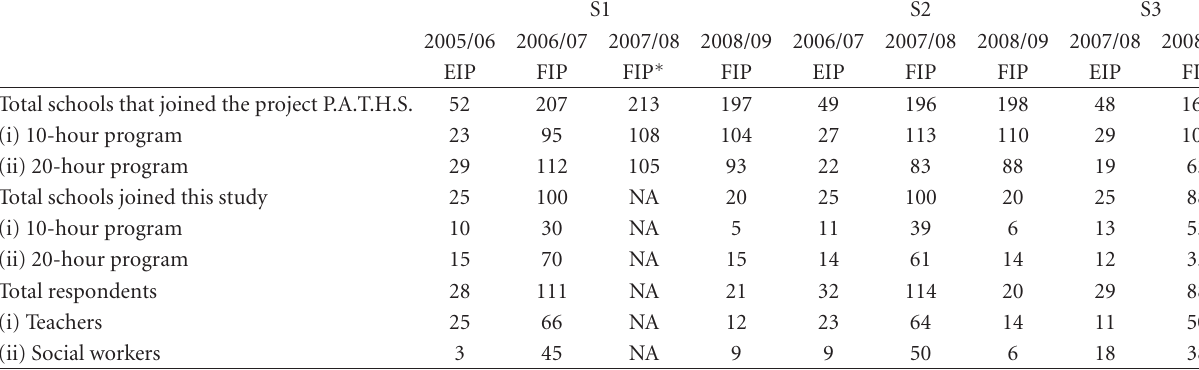
Table 1: Di ff erent datasets used in the integrative study.